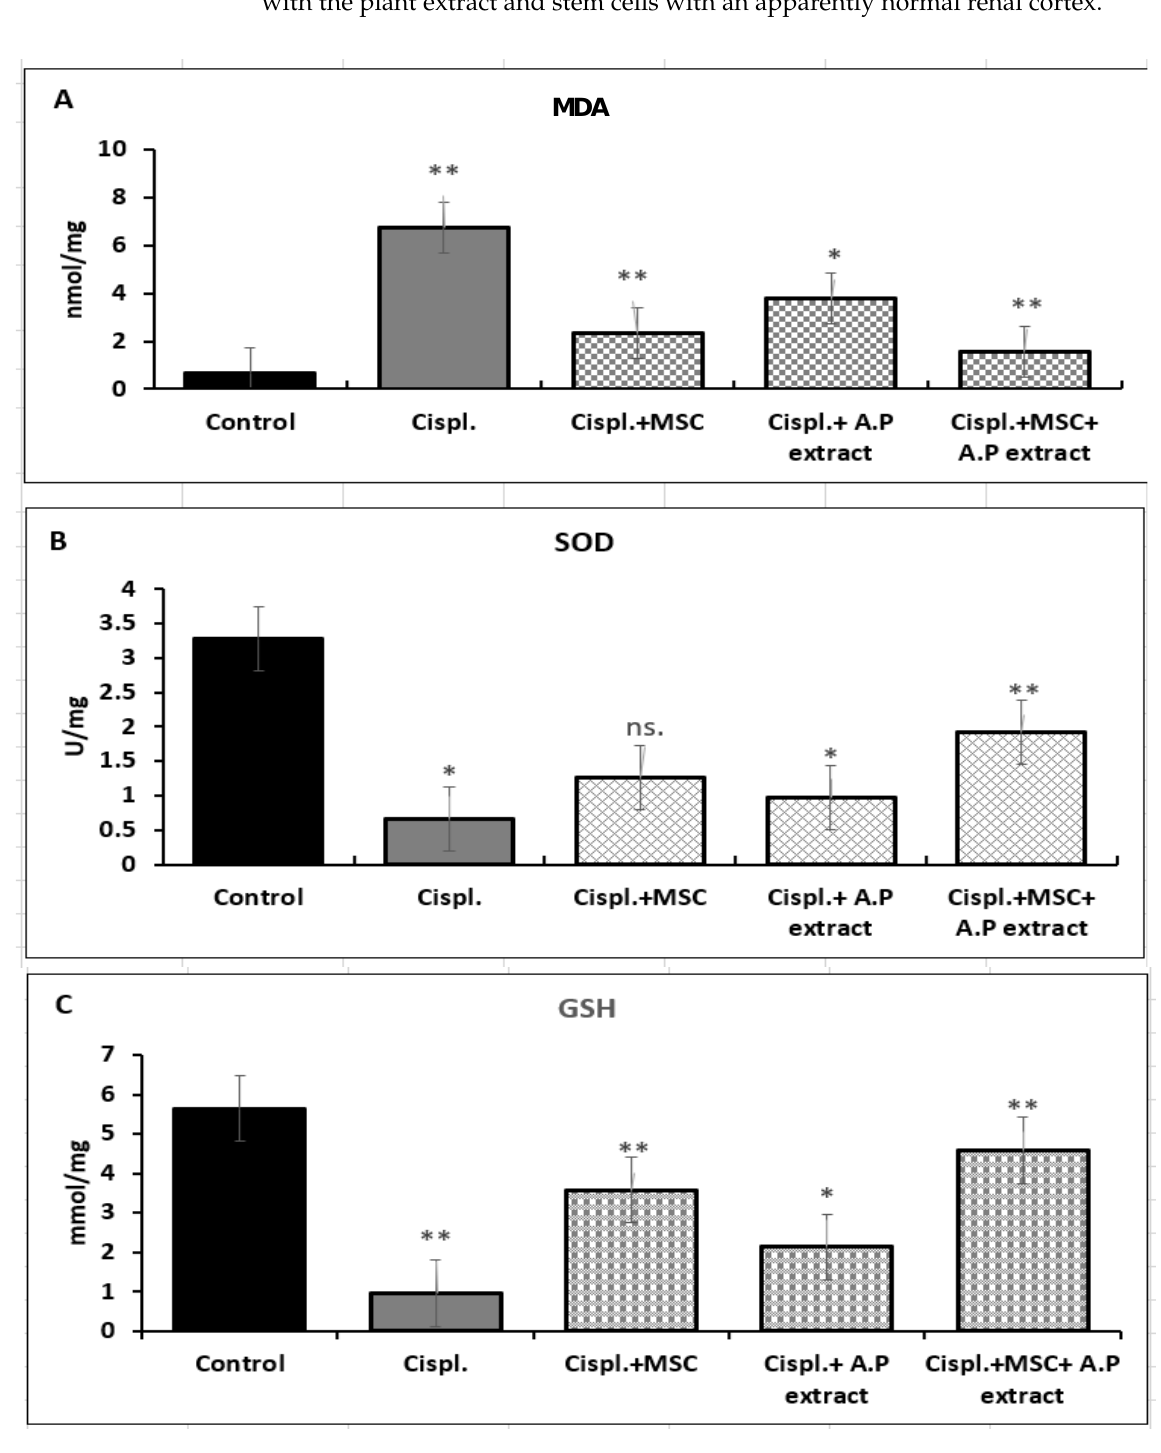
Figure 2. Oxidative stress markers MDA, SOD, and GSH. C: control, Cispl.: positive control, Cispl. + MSC: cisplatin with mesenchymal stem cells, Cispl. + A.P extract: cisplatin with Asian pigeonwing extract, Cispl. + MSC + A.P: cisplatin with mesenchymal stem cells and Asian pigeonwing extract. ( A ) MDA, ( B ) SOD, and ( C ) GSH. Values are shown as mean ± SD and ns ( p > 0.05), * ( p < 0.05), ** ( p < 0.01), *** ( p < 0.001) compared to the corresponding value in the control group.